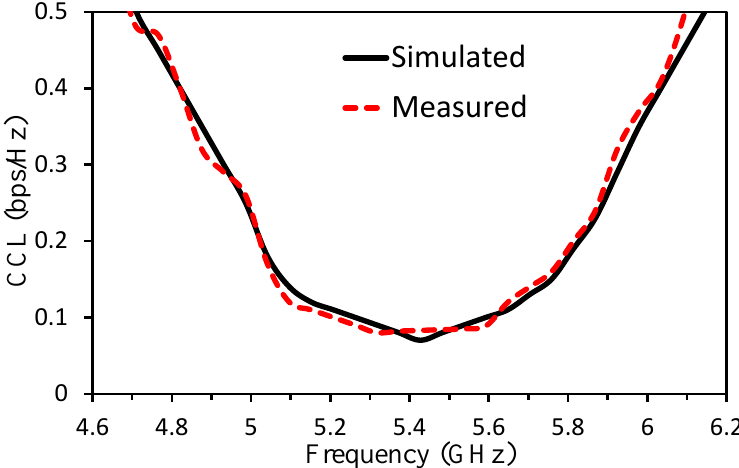
Figure 9. Simulated and measured CCL of the antenna in the presence of decoupling